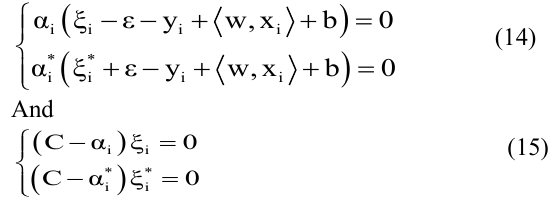
Fig. 1. Soft margin loss setting for a linear